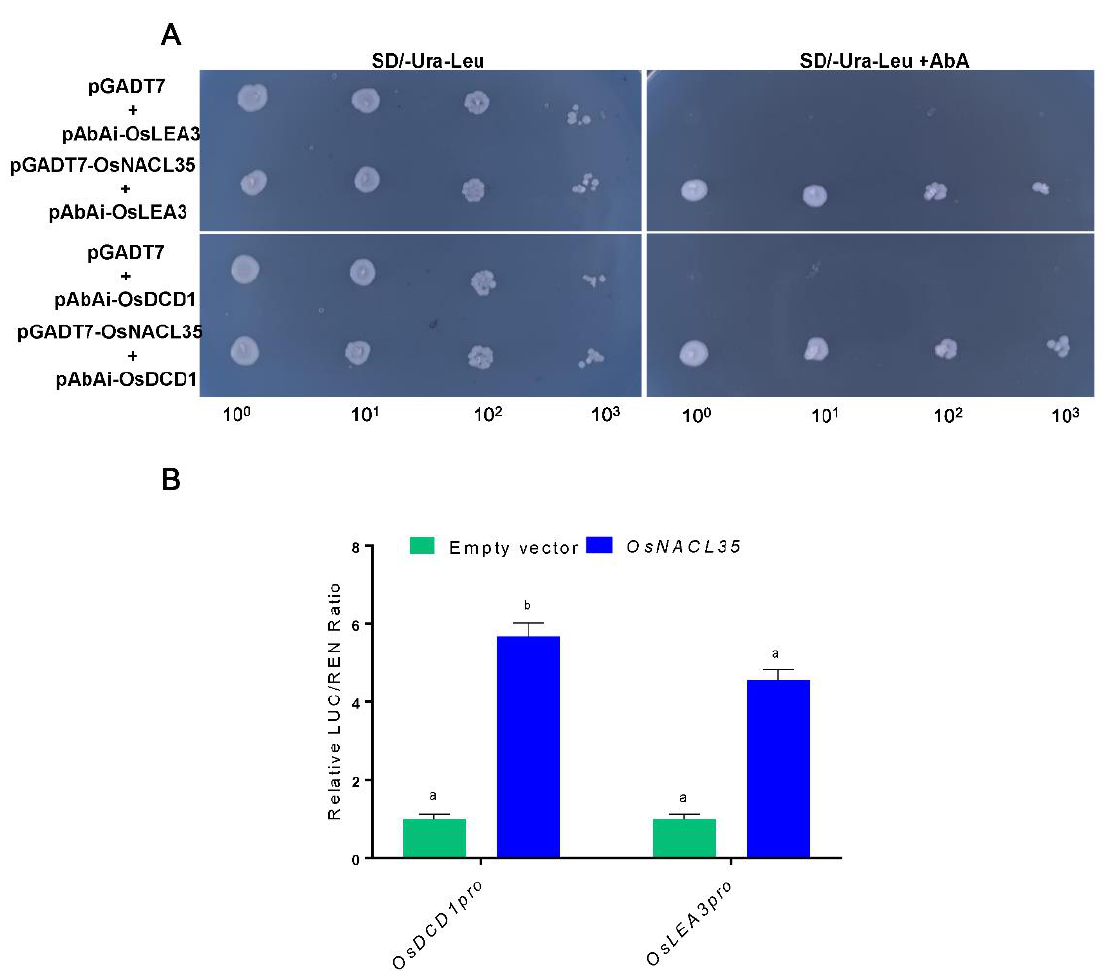
Figure 9. OsDCD1 and OsLEA3 are the direct target genes of OsNAL35. ( A ) Interaction of OsNACL35 with the promoters of OsDCD1 and OsLEA3 through yeast one-hybrid assays. The yeast cells were grown on SD/-Leu/-Ura/+AbA medium. ( B ) Interaction of OsNACL35 with the promoters of OsDCD1 and OsLEA3 by dual-luciferase reporter activation assays in tobacco. Three independent experiments were conducted, showing similar results. Statistical analyses were performed by a two- way ANOVA, followed by a Tukey’s multiple comparison test. Different letters indicate significant differences at p < 0.05.